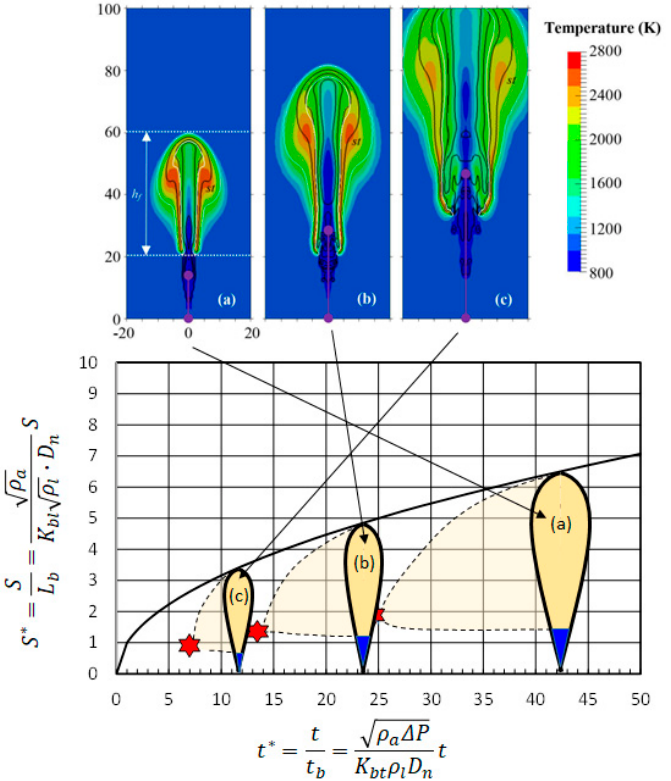
Figure 33. Diesel spray combustion analysis based on breakup scaling. ( a ): Case 3 with 0.100 mm nozzle, ( b ): Case 4 with 0.180 mm nozzle, and ( c ): Case 5 with 0.363 mm nozzle. Mark shows the ignition location and time, and illustration shows the spray flame configuration at snapshot timing in the simulation.